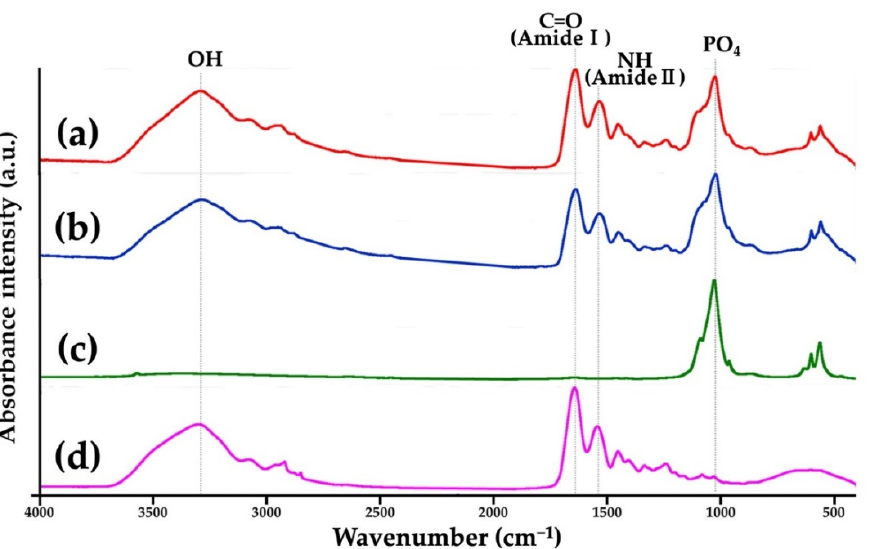
Figure 6. FTIR charts of ( a , b ) two Col/Hap composites (AI 20 min 5Cy Col/Hap and AI 60 min 5Cy Col/Hap), ( c ) Hap standard, and ( d ) Col control.